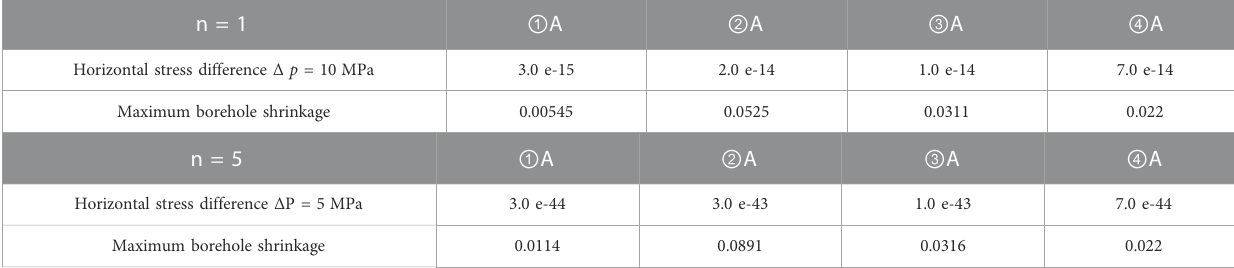
TABLE 4 The pre-coef fi cient A and the exponent n (Layer No. 2), in the case of n = 1 and